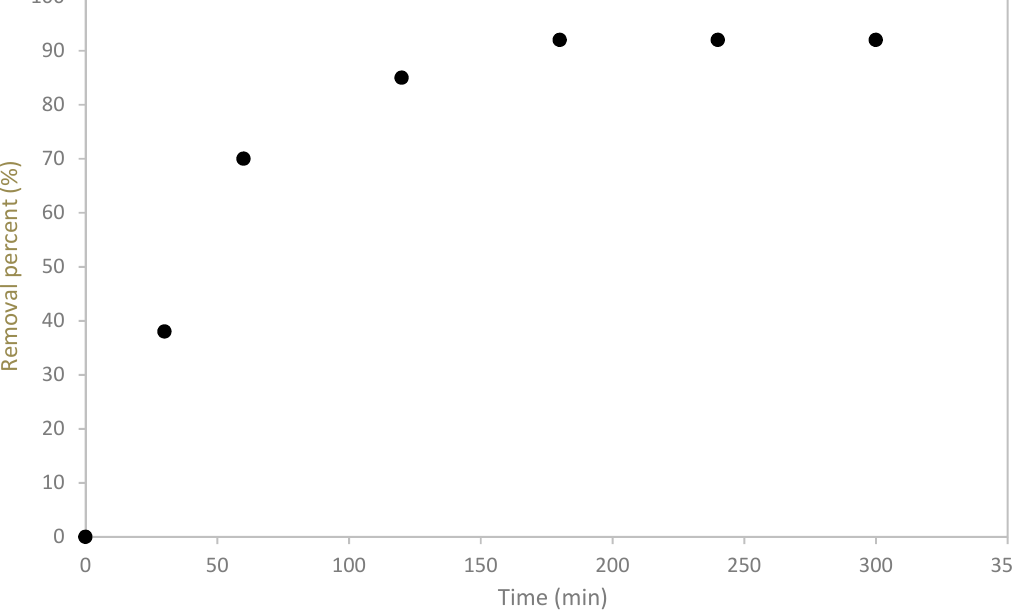
Figure 3. The effect of contact time on the removal of copper by olive mill solid waste.